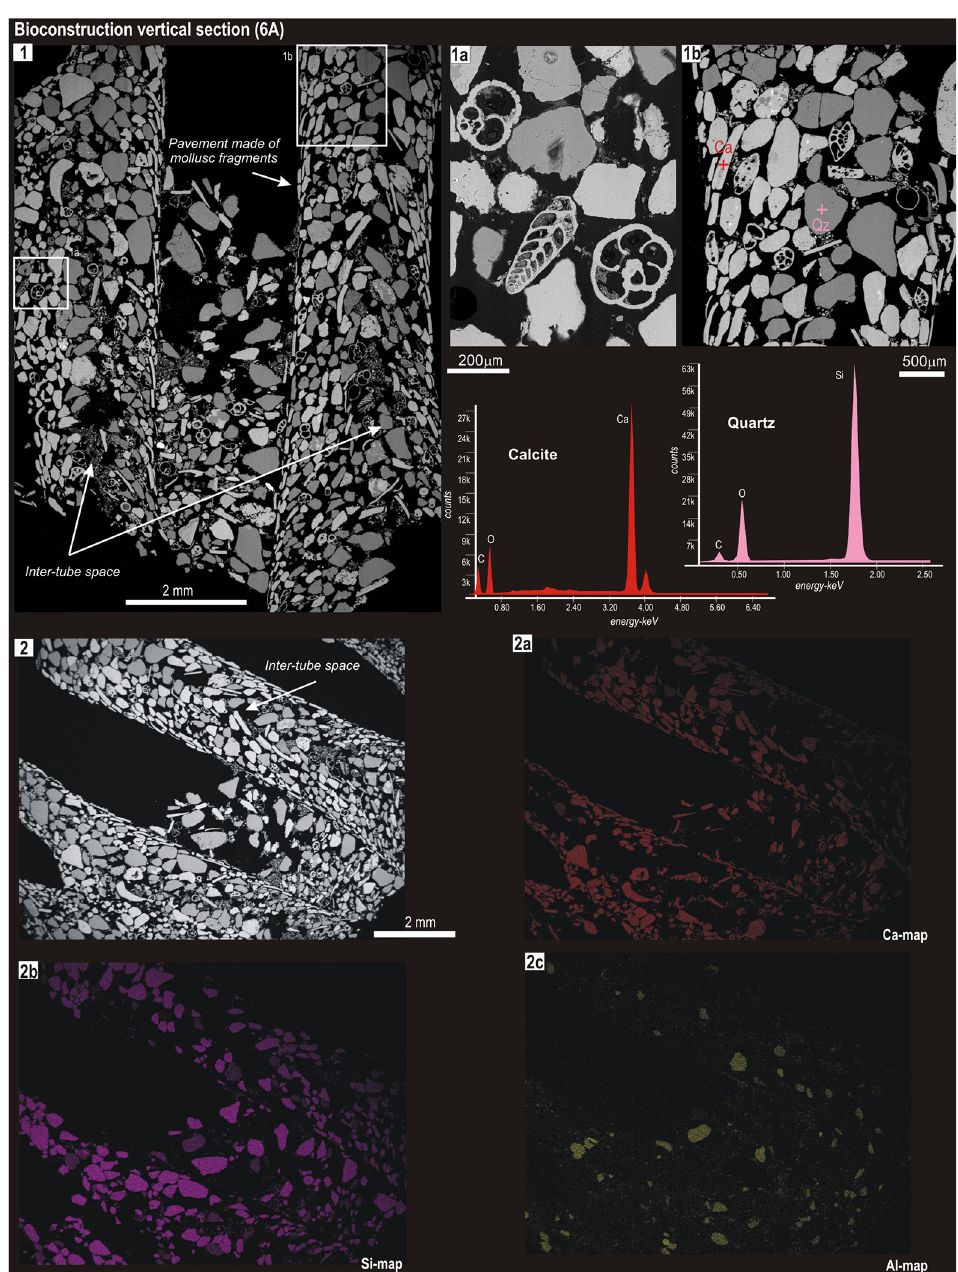
Fig 3. BSE image of aggregated tubes (the same of Fig 2; photo 2) vertically sectioned (6A). For further details in this figure, see also caption of Fig 2. The particles were of variable shape and size, from a minimum of 4.5 μ m to a maximum of about 92 μ m, and with surfaces characterized by cracks and pits (Fig 4, arrow in 1a), likely due to oxidative weathering. The compositional spectra had a typical carbon peak, with minor amounts of Si, Al, S, Na, K, Ti, Fe and Cl, suggesting a probable plastic origin (Table 1). The presence of Cl, the distinctive element of polyvinyl chlorine (PVC) [39], confirmed that some of those particles were in fact microplastics (Fig 4; SP-2, SP-3; SP-5; Table 1). Other